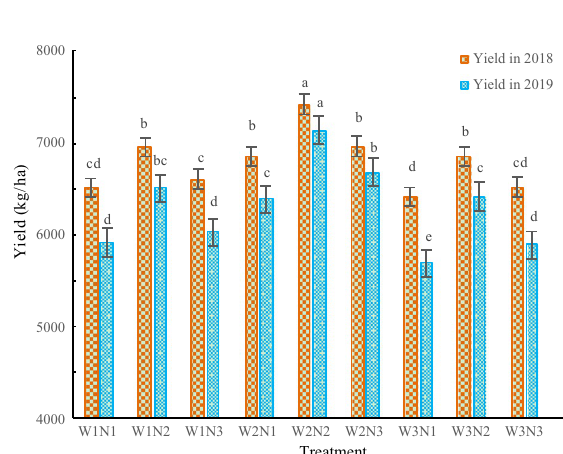
Figure 4. The effects of the different treatments on the yield of Isatis indigotica . The values shown are the mean ± SD, n = 3. Asterisks indicate a significant difference at the P ≤ 0.05